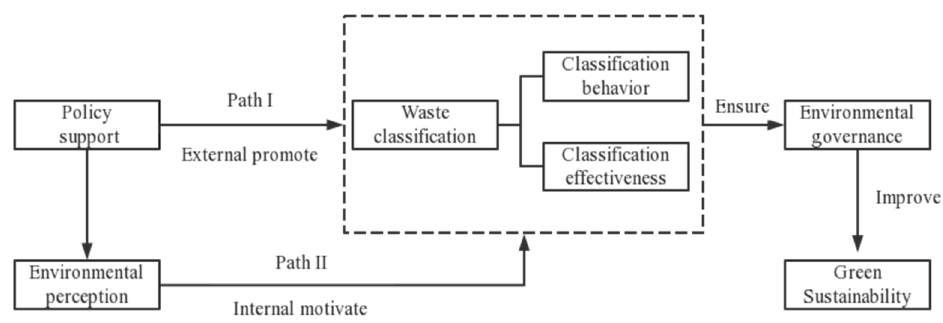
Figure 1. Theoretical analysis model.